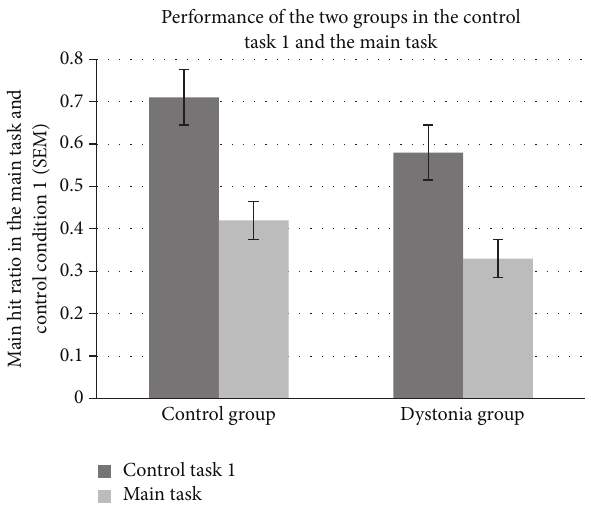
Figure 3: Performance in the main task and the control task